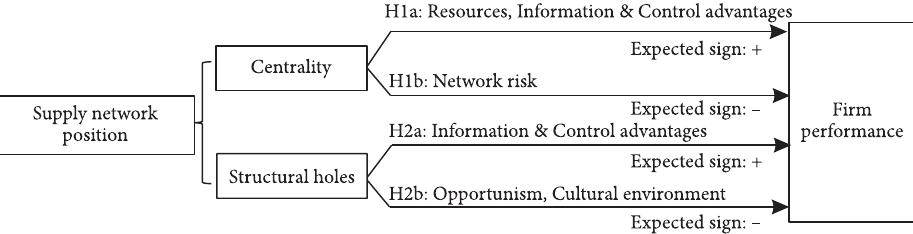
Figure 1. Research hypotheses: the influence of supply network position on firm